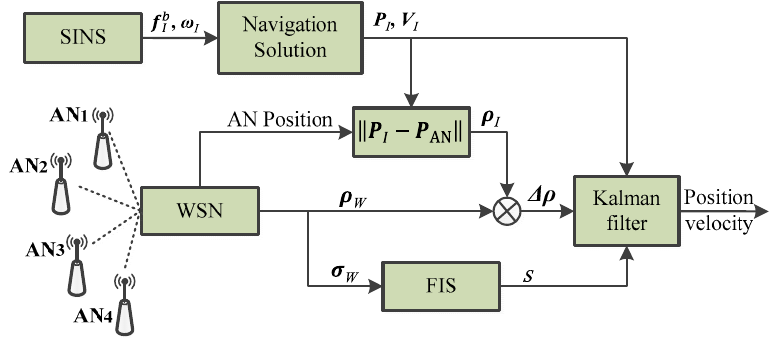
7 of 19 Figure 4. Measured distance values after the LSR correction. 4. Fuzzy Adaptive Tightly-Coupled Integrated Model 4.1. Structure of Tightly-Coupled Integration The SINS/WSN FATCI architecture is shown in Figure 5. Firstly, the position and velocity of SINS can be calculated through the navigation solution algorithm, which uses the specific force (denoted as (cid:2188) (cid:3010)(cid:3029) ) and angular rate (denoted as ω I ). Meanwhile, the measured distances (denoted as ρ W ) between the four anchor nodes and the mobile node are obtained by WSN. Moreover, the covariance of ρ W can also be calculated. Secondly, the pseudo - distances (denoted as ρ I ) between the SINS and four anchor nodes are calculated based on the positions of anchor nodes and the position of a mobile target measured by SINS. The difference ( Δ ρ ) between the pseudo-distance ( ρ I ) and